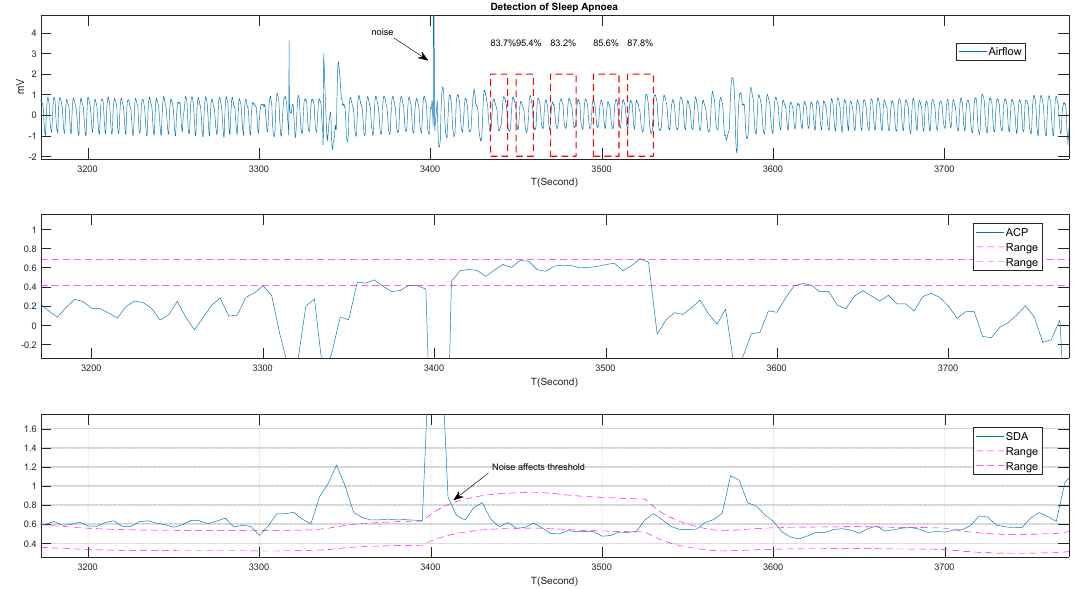
Figure 5. Dynamic threshold of SDA increases because of movement noise, which causes false alarms. OSAHS has serious and life-shortening consequences including cardiovascular disease, diabetes, poor quality of life, depression, and automobile accidents caused by falling asleep [39]. However, waiting times for PSG diagnosis in the United States and United Kingdom were estimated to be 2–10 and 7–60 months, respectively [40]. A study reported a median waiting time of 152 days in 2009 to 92 days in 2012 ( p < 0.0001) by home based PM [41]. A reliable PM may be used for general population screening as a result. Our study provides an airflow sensing algorithm with overall sensitivity of 74%, specificity of 100%, and accuracy of 80.0% for mild to moderate OSAHS. If the airflow in the PM screening of a patient represents an AHI of > 15, the physician could preferentially arrange a PSG follow-up. Moreover, when applied to the airflow sensed by an oronasal thermal sensor under the mask, our algorithm may provide an accuracy of 85% and therefore assist with determining